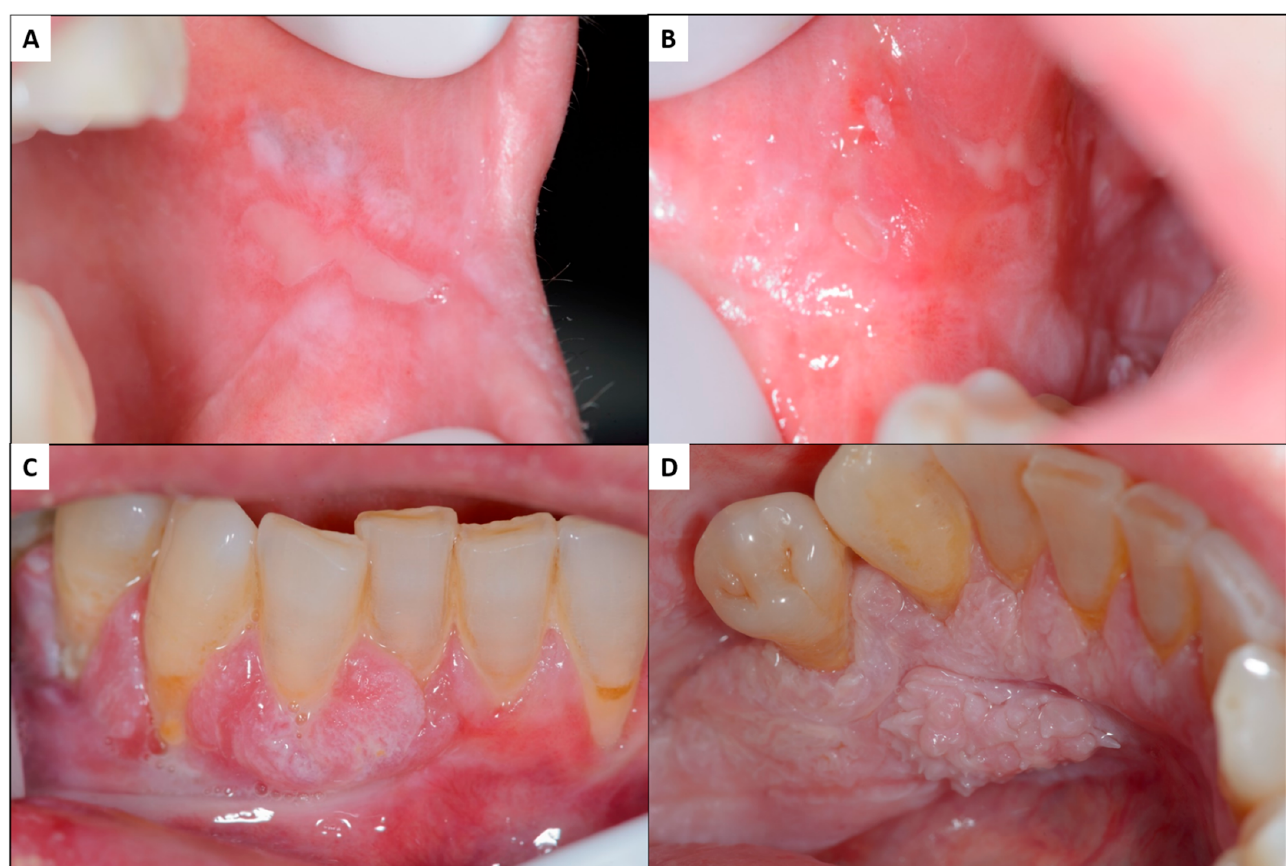
Figure 2. Malignant transformation of oral lichen planus: patient with oral lichen planus affecting both buccal mucosa with erosive atrophic lesions combined with white reticular and plaque lesions ( A , B ). In the anteroinferior gingiva, there are exophytic tissue masses, both in the vestibular and lingual areas, which, in the histopathologic, study proved to be oral squamous cell carcinomas ( C,D ) [5].